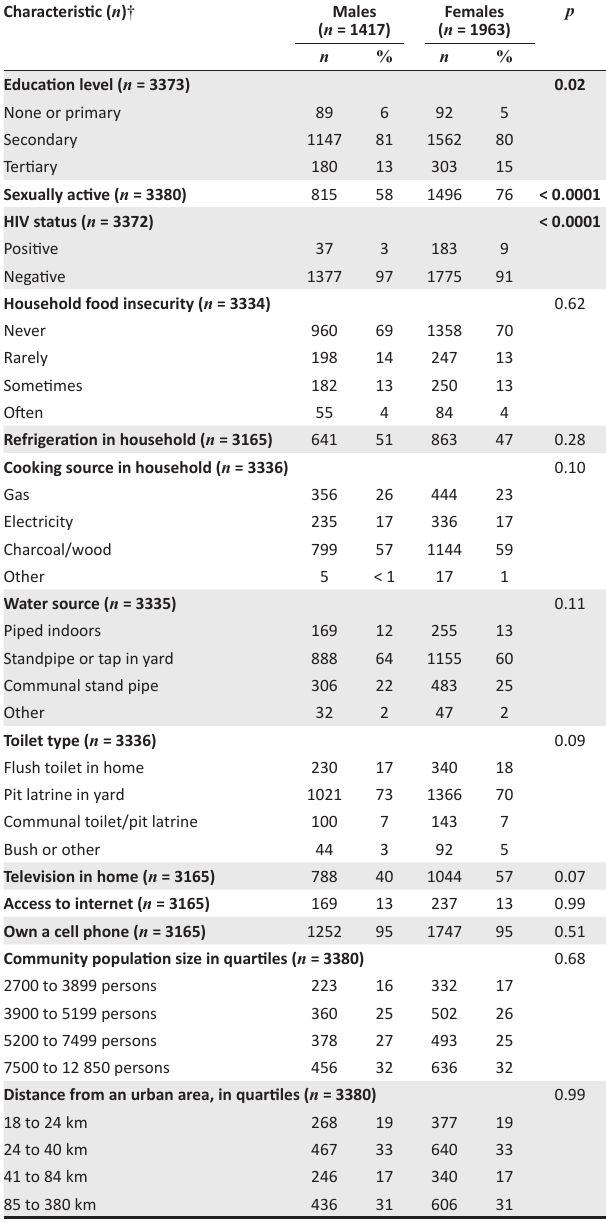
TABLE 1: Summary of socio-demographic characteristics of adolescents and young adults (aged 16–24 years) by gender. Characteristic ( n )